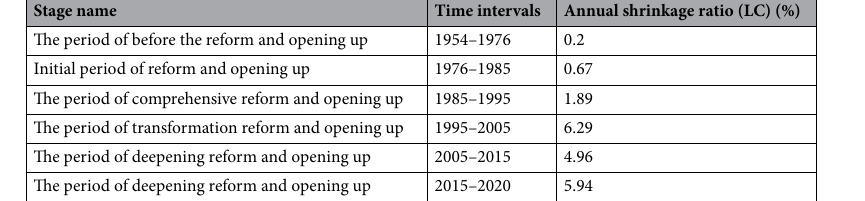
Table 4. Annual degeneration rate of the marsh in typical transect.